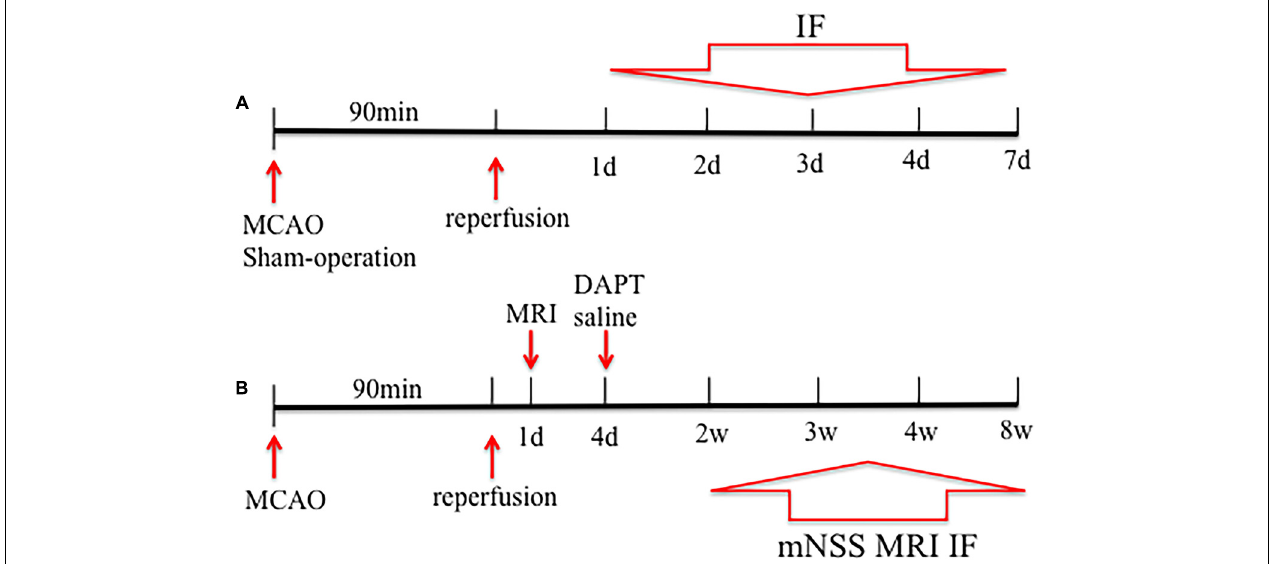
FIGURE 1 | Study design of the experiment. Rats were subjected to middle cerebral artery occlusion (MCAO) in (A,B) . (A) Five rats were sacrificed before and 1, 2, 3, 4, and 7 days after stroke, and subjected to immunohistochemical analysis. (B) Rats were treated by DAPT or saline at day4, and eight rats of each subgroup were successively performed with behavioral test, magnetic resonance imaging (MRI) and the subsequent decapitation for immunohistochemical analysis 2, 3, 4, and 8 weeks after stroke.